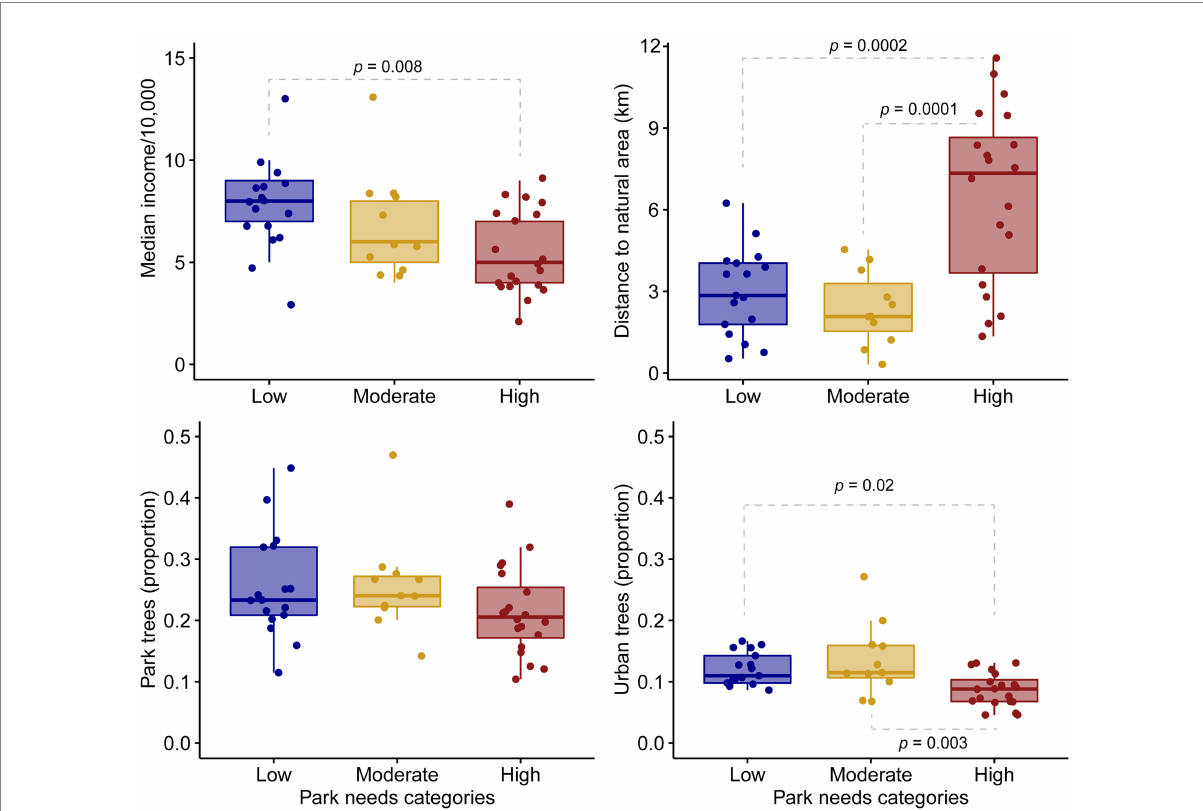
FIGURE 3 Box plots depicting patterns of median income, distance to the closest large natural area (km), the proportion of tree cover within parks [Park trees (proportion)], and the proportion of tree cover adjacent to parks [Urban trees (proportion)] across a gradient of low-, moderate-, and high-park needs. Dotted gray lines linking boxes indicate significant differences based on a one-way ANOVA and Tukey–Kramer test, or a Kruskal–Wallis rank-sum test followed by a nonparametric multiple-comparisons procedure, based on relative contrast effects. We used a Bonferroni adjusted value of p of 0.05/3 = 0.02 to account for the three comparisons made within